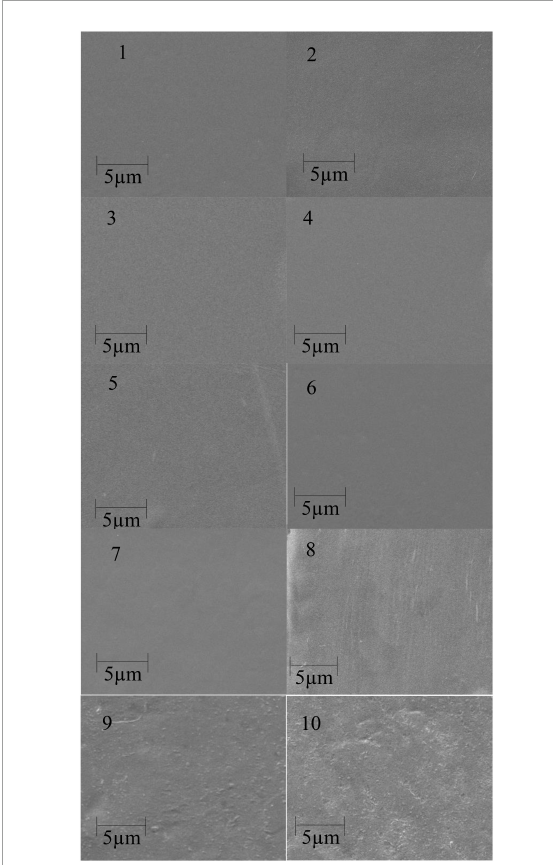
FIGURE1 Scanning electronic microscope (SEM) surface images of pure corn starch (1) and the films containing 5% (2–4), 10% (5–7), and 15% (8–10) Accountium heterophyllum, Artemisia annua , and Thymus serpyllum medicinal plants.